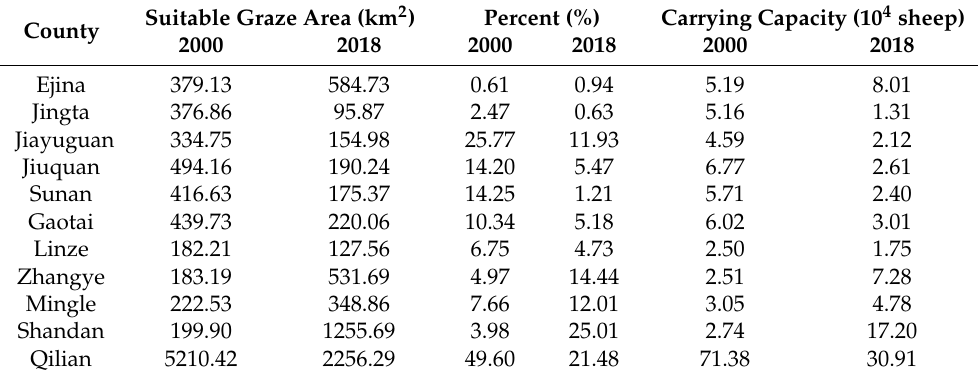
Table 5. The suitable graze area and carrying capacity in the Heihe River Basin from 2000 to 2018.